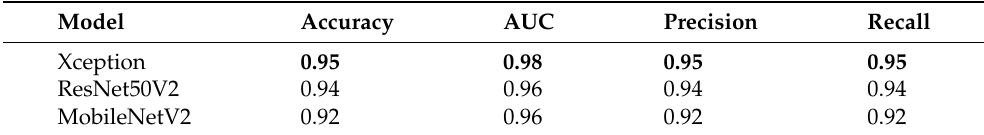
Table 10. Model performance on the second test dataset, obtained from